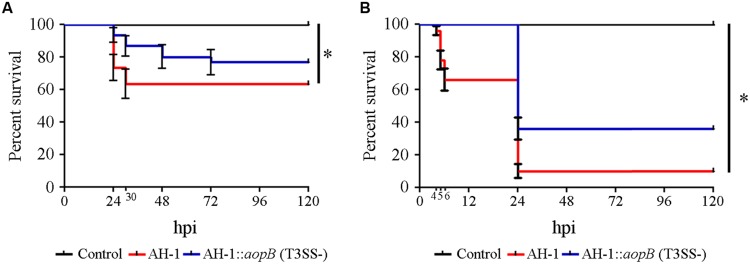
Implications of the T3SS in the pathogenesis of Aeromonas hydrophila. (A) Kaplan–Meier survival curve of healthy larvae after infection with bacterial suspensions. *Significant differences at P < 0.005. (B) Kaplan–Meier survival curve of injured larvae after infection with bacterial suspensions. *Significant differences at P < 0.0001. In all cases, the graphs show representative results of five independent experimental infections conducted using four biological replicates of ten larvae each. Healthy and injured larvae were infected with a bacterial suspension (AH-1 wild-type or AH-1::aopB) containing 2 × 107 CFUs·mL-1 and 5 × 107 CFUs·mL-1, respectively.